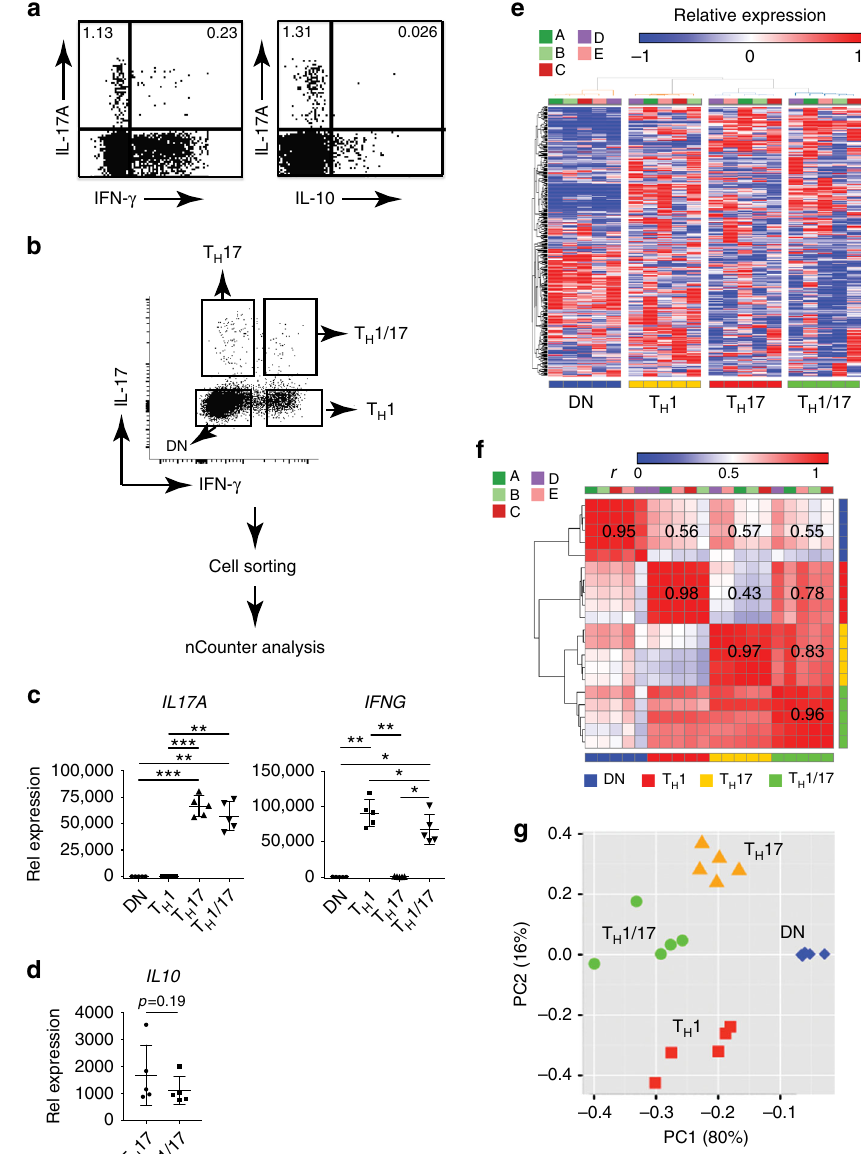
Fig. 1 Transcriptionally distinct human T H 17 subsets in peripheral blood. a IFN- γ and IL-10 expression in human T H 17 cells. Isolated PBMCs were stimulated with PMA and ionomycin for 4 h. Production of indicated cytokines in CD4 + T cells were assessed by fl ow cytometry with intracellular cytokine staining assay. Dotplots shown were gated on CD4 + lymphocytes. Data are representative of two independent experiments with similar results. b Isolation of live T H 1/17, T H 17, T H 1, and DN cells from human PBMC for nCounter analysis. CD4 + T cells isolated from the peripheral blood of healthy donors were stimulated with PMA and ionomycin for 3 h. CD3 + CD4 + -T H 1/17 (IFN- γ + IL-17 + ), T H 17 (IFN- γ − IL-17 + ), T H 1 (IFN- γ + IL-17 − ), and DN (IFN- γ − IL-17 − ) cells were sorted after being stained with fl uorescence-conjugated anti-CD3 and CD4 in combination with cytokine secretion detection kits (Miltenyi) ( n = 5).